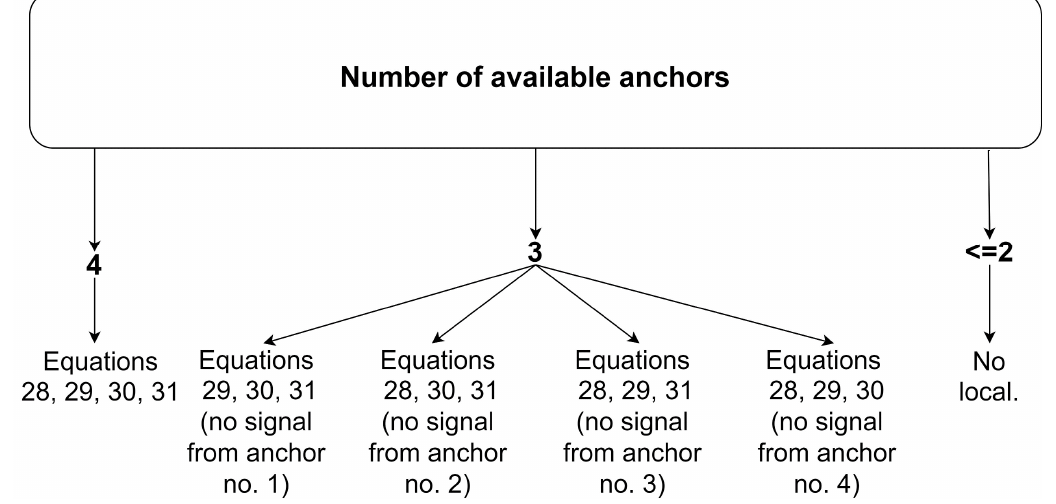
Figure 10. Conditional scheme of equation selection for cost function f(x) in nonlinear programming algorithm.